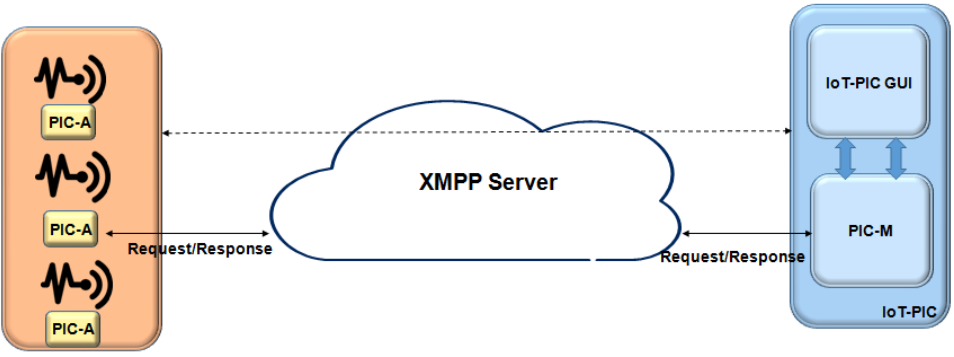
Figure 9. Illustration of the IoT-PIC